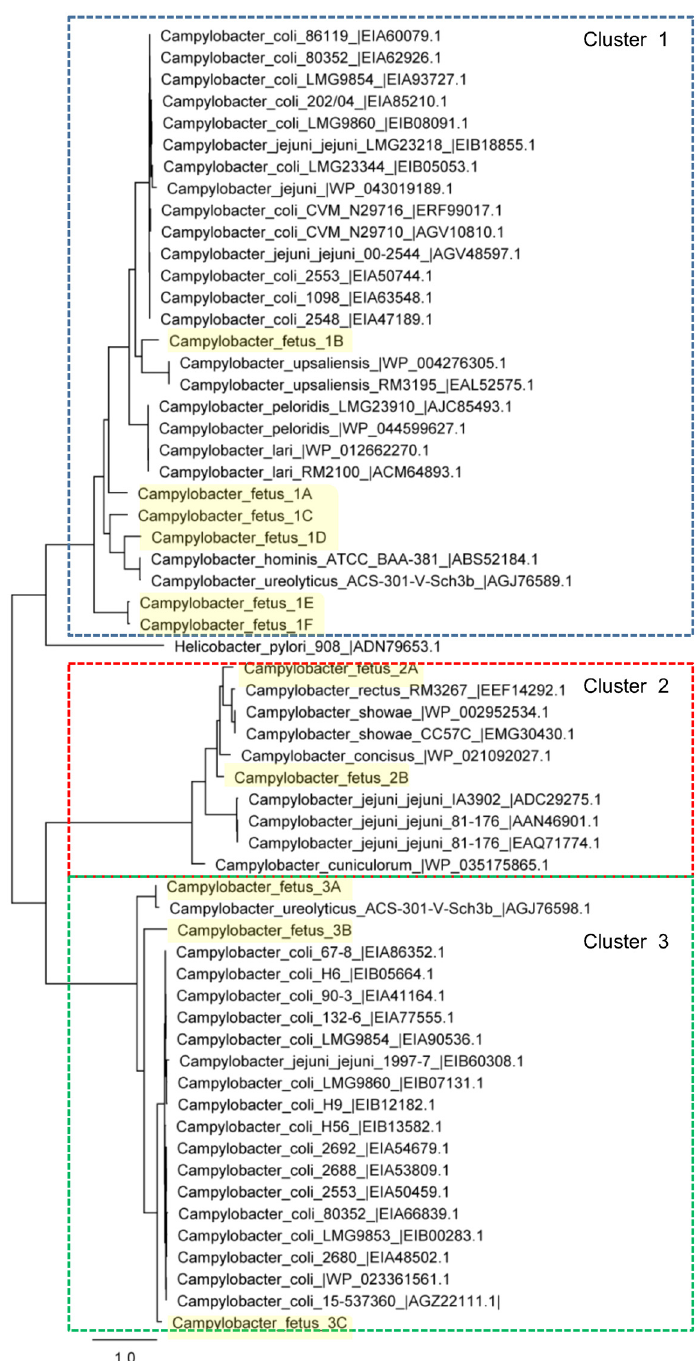
Fig 3. Phylogenetic analysis of virD4 proteins of different Campylobacter species. The scale bar represents branch length (number of amino acid substitutions/100 residues). Related VirD4 proteins are indicated in